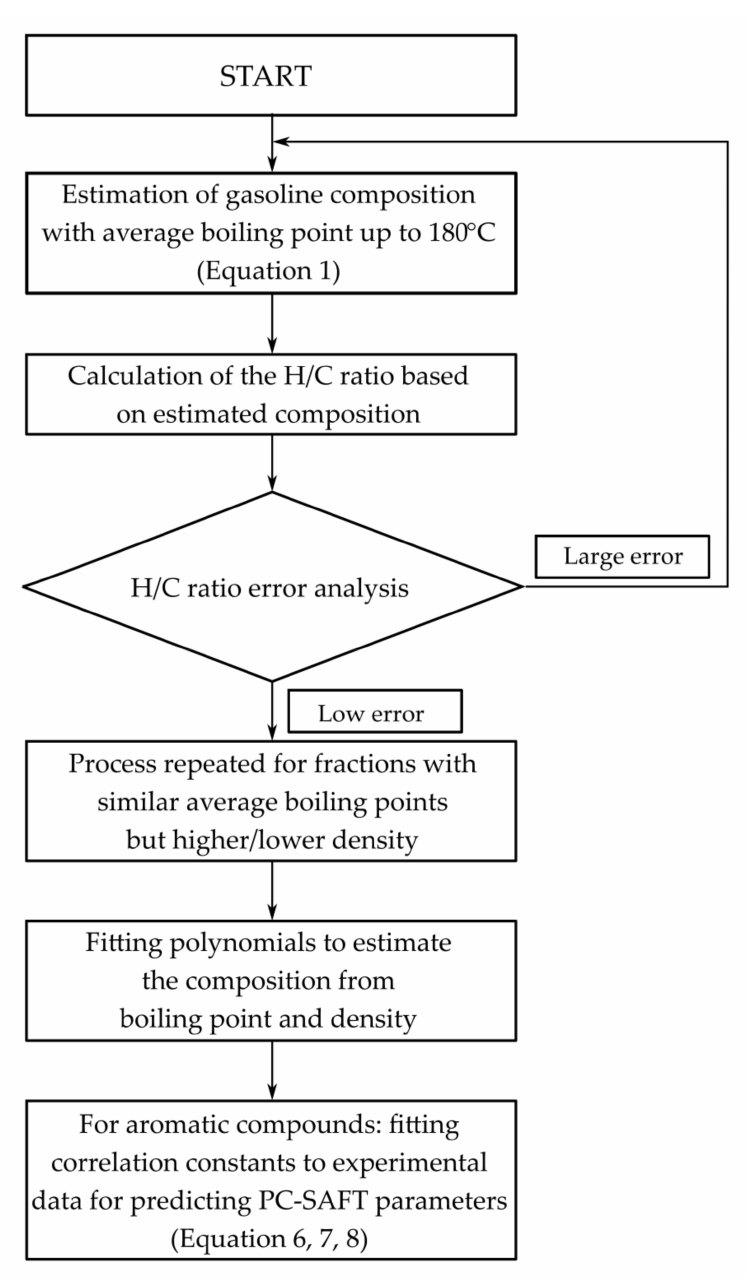
Figure 1. The modeling procedure used in this work for shale oil gasoline